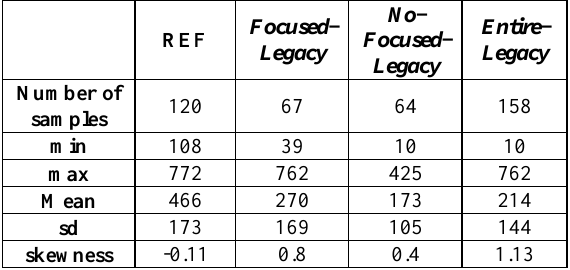
Table 1: Statistical measurements of clay contents